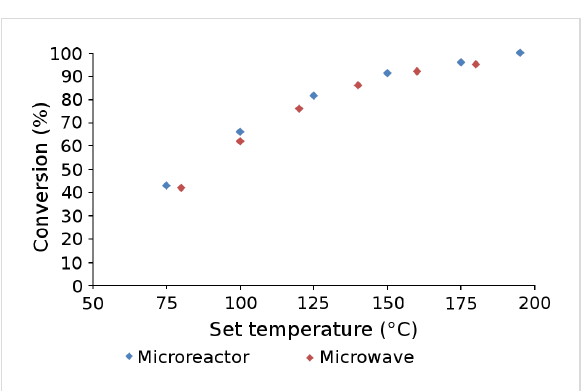
Figure 5: Comparison of the results obtained in Labtrix ® S1 with reported data generated in a microwave synthesiser.